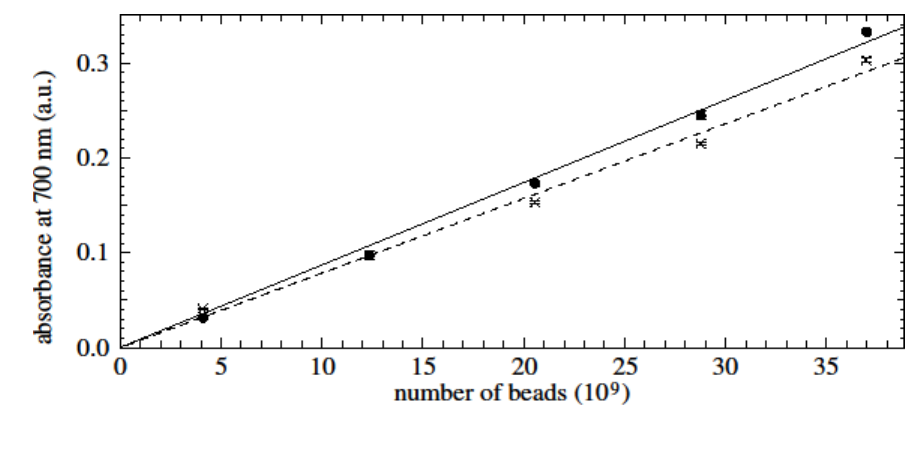
Figure 3. Standard curves for the number of magnetic beads with (solid line, dots) or without peripheral blood mononuclear cells (PBMC) (dashed line, crosses). For both standard curves R 2 = 0.99. In this and later figures, data points are the mean of triplicate values. Vertical lines (sometimes smaller than the plotted points) indicate the range of